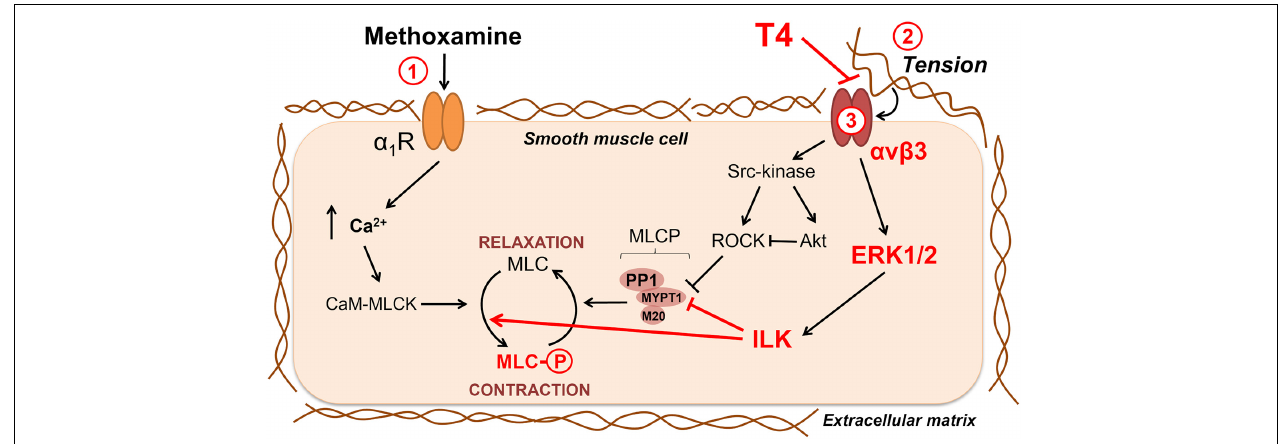
FIGURE 8 | Potential signaling pathways involved in non-genomic relaxation of rat skeletal muscle artery in response to thyroxine. T4 induces endothelium-independent vasorelaxation due to suppression of extracellular matrix signaling, in detail: 1—contraction in response to α 1 -adrenoceptor agonist methoxamine increases arterial wall tension; 2—the tension activates integrin α v β 3 and downstream procontractile ERK1/2 signaling pathway which includes ILK and its targets MLCP and MLC; 3—T4 interacts with integrin α v β 3 at the site overlaying the site recognizing the extracellular matrix and, thereby, weakens the integrin signaling and methoxamine-induced contraction. Key participants of T4-induced vasorelaxation discovered in our study are shown in red. Src-kinase, ROCK and Akt also may participate in integrin-dependent signaling, but our data do not support their role in T4-induced vasorelaxation in skeletal muscle arteries. Sharp arrows show activation and blunt arrows—inhibition of the targets. α 1 R, α 1 -adrenoceptor; CaM, calmodulin; ILK, integrin-linked kinase; MLC, myosin light chain 2; MLCK, myosin light chain kinase; MLCP, myosin light chain phosphatase; MYPT1, PP1 and M20 are subunits of MLCP; ROCK, Rho-kinase.